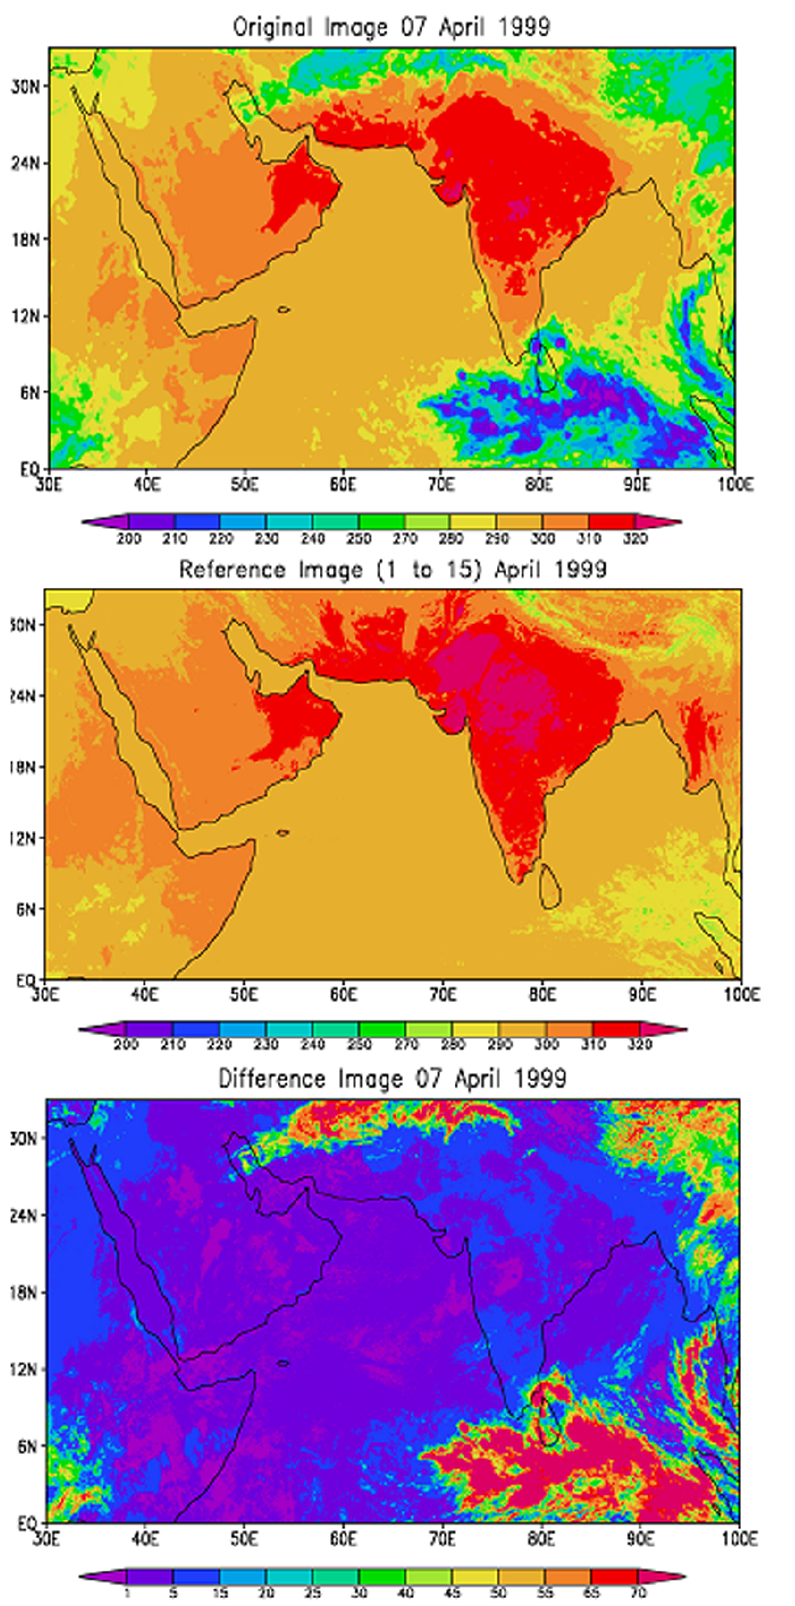
Fig. 2. (a) An example of an original IRBT image, (b) reference image for first 15 days of April 1999, (c) an example of a difference